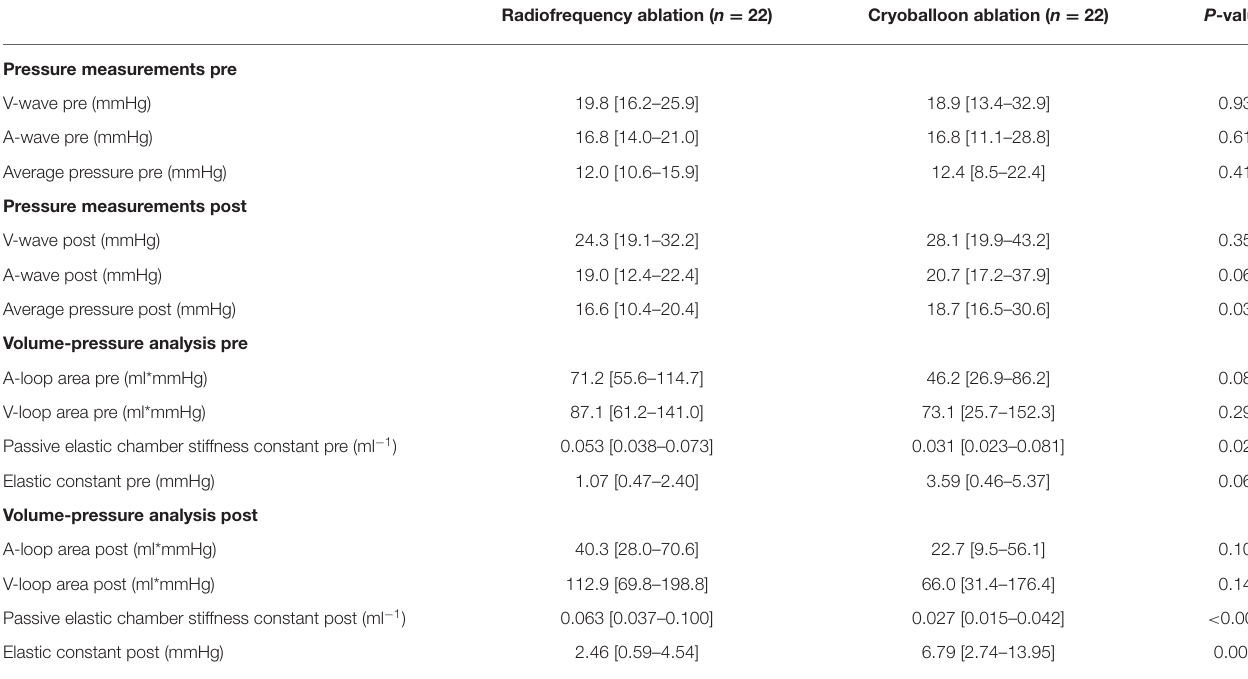
TABLE 4 | Pressure data and volume-pressure variables by ablation